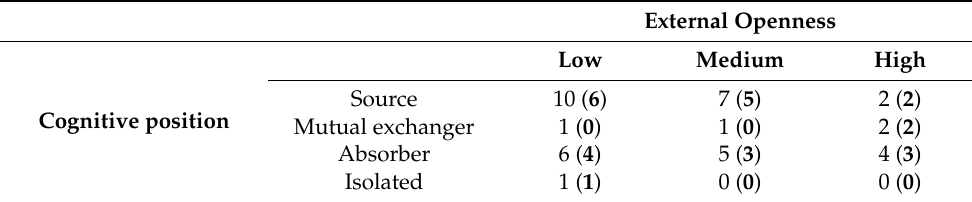
Table 4. Cognitive roles: technological knowledge exchange 1 .